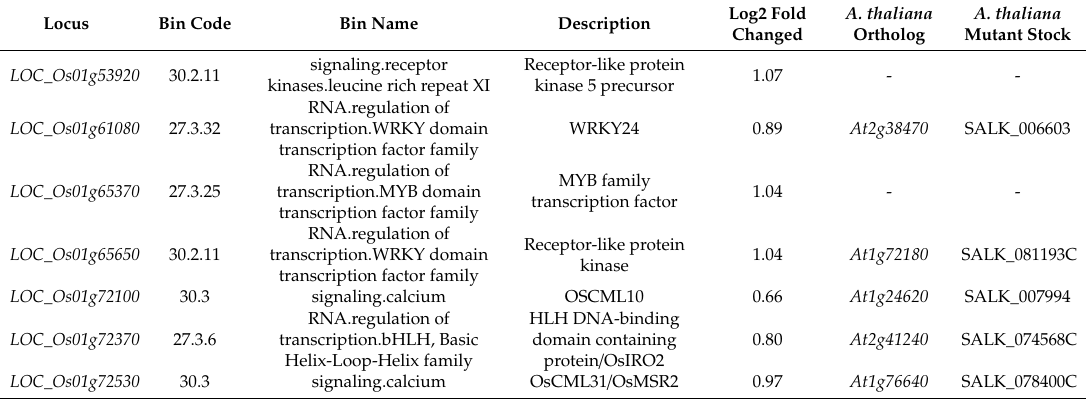
Table 1. Regulatory genes located on the salt tolerance QTL from chromosome 1 enriched from MapMan analysis compared between ’KDML105’ and CSSL18 after 2 days of salt